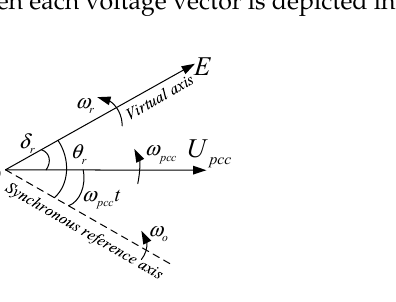
Figure 3. Vector diagram of synchronous reference axis defining and voltage vector orientation.